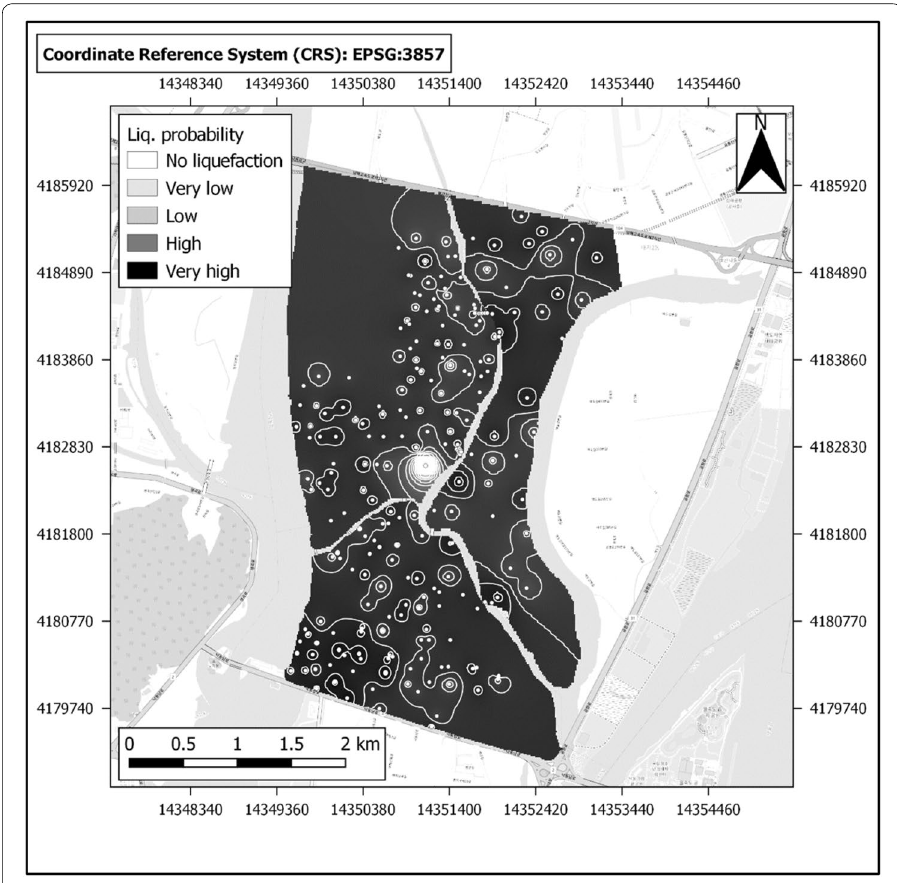
Fig. 23 Liquefaction hazard map based on reliability method for case